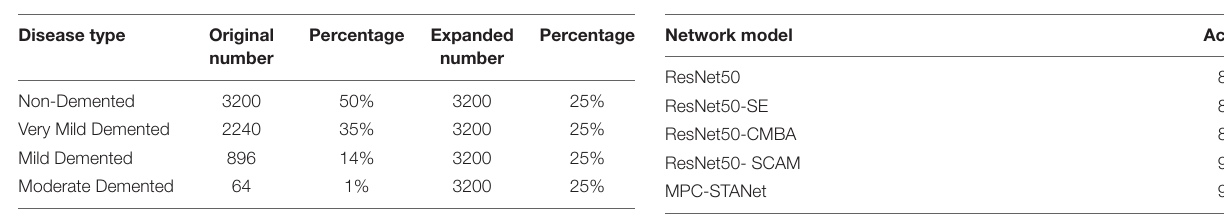
TABLE 1 | The number of the four disease stages and their proportions.